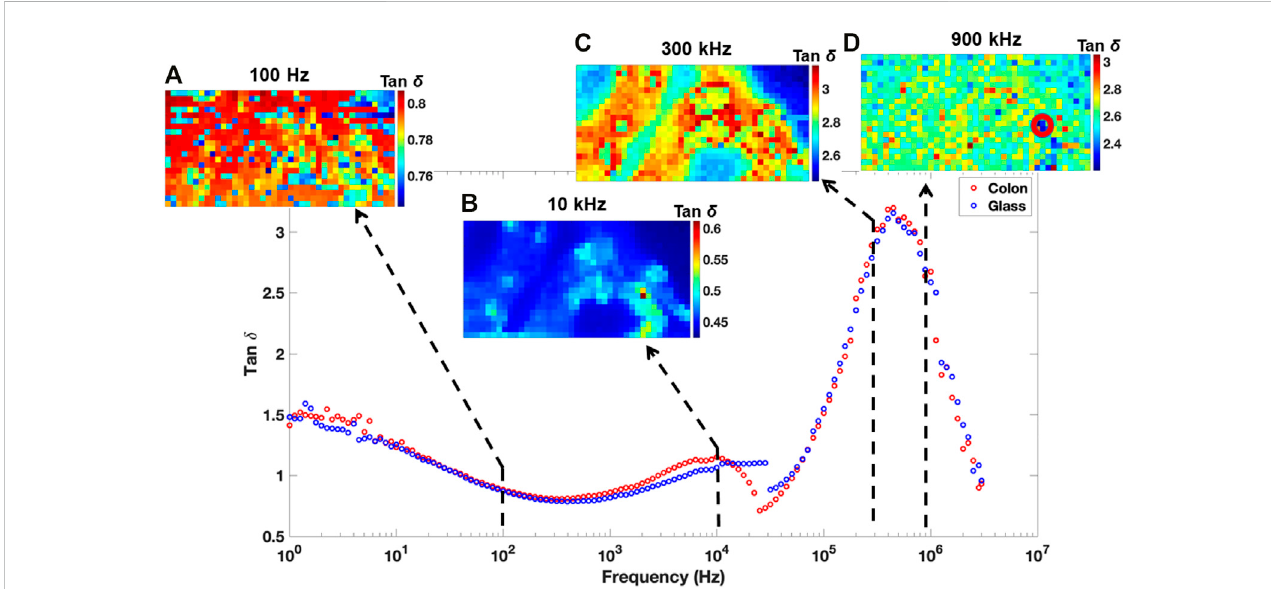
FIGURE 5 Losstangentmapsat100 Hz (A) ,10 kHz (B) ,300 kHz (C) ,and900 kHz (D) ,frequenciessuperimposedontoarepresentativefrequencyvs.tan δ pro fi leof micro-sectioned colon tissue. The position of the probe during the frequency sweep is marked with red circle in the 900 kHz